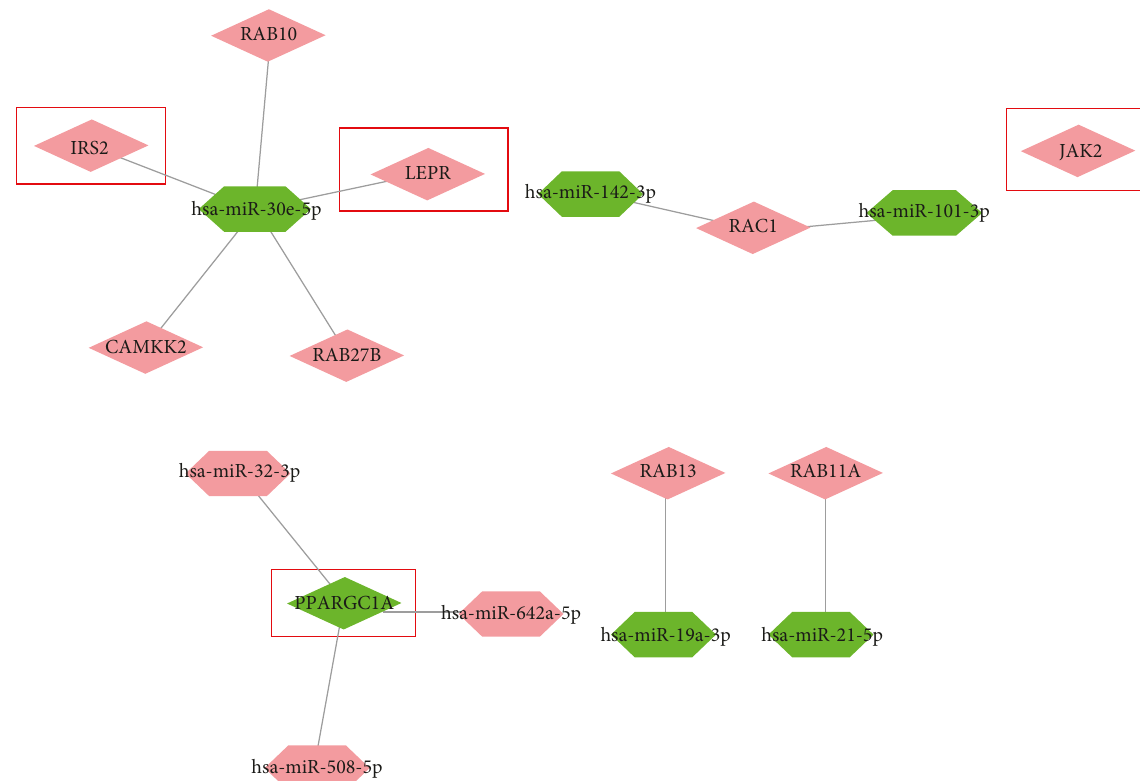
Figure 6: Optimized miRNA-mRNA regulatory network. The regulatory network consists of 10 optimized genes, JAK2, CAMKK2, RAB27B, LEPR, RAC1, IRS2 , and PPARGC1A , and their corresponding miRNAs, miR-30e-5p, miR-142-3p, miR-101-3p, miR-32-3p, miR-508-5p, miR-642a-5p, miR-19a-3p, and